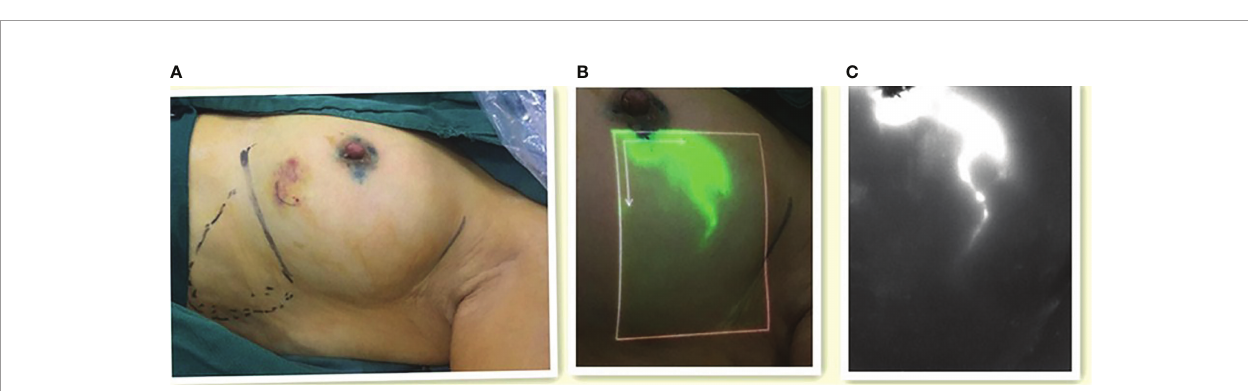
FIGURE 2 | The images of lymphatic drainage. (A) Left one: ICG was injected around the areola. (B) Middle one: The image of lymphatic drainage on the skin with the LFIS. (C) Right one: The image of lymphatic drainage on the monitor with the Langfang Vascular